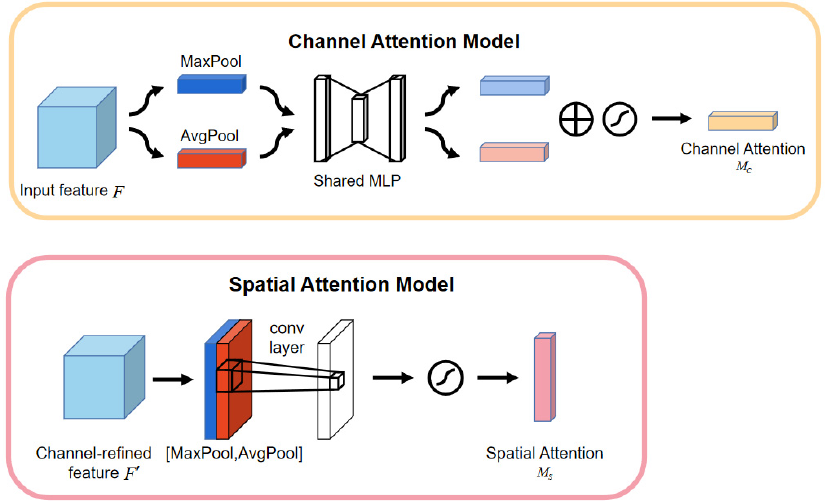
Figure 5. Structure of the spatial attention module and the channel attention module in the CBAM module for adaptive adjustment of feature maps.